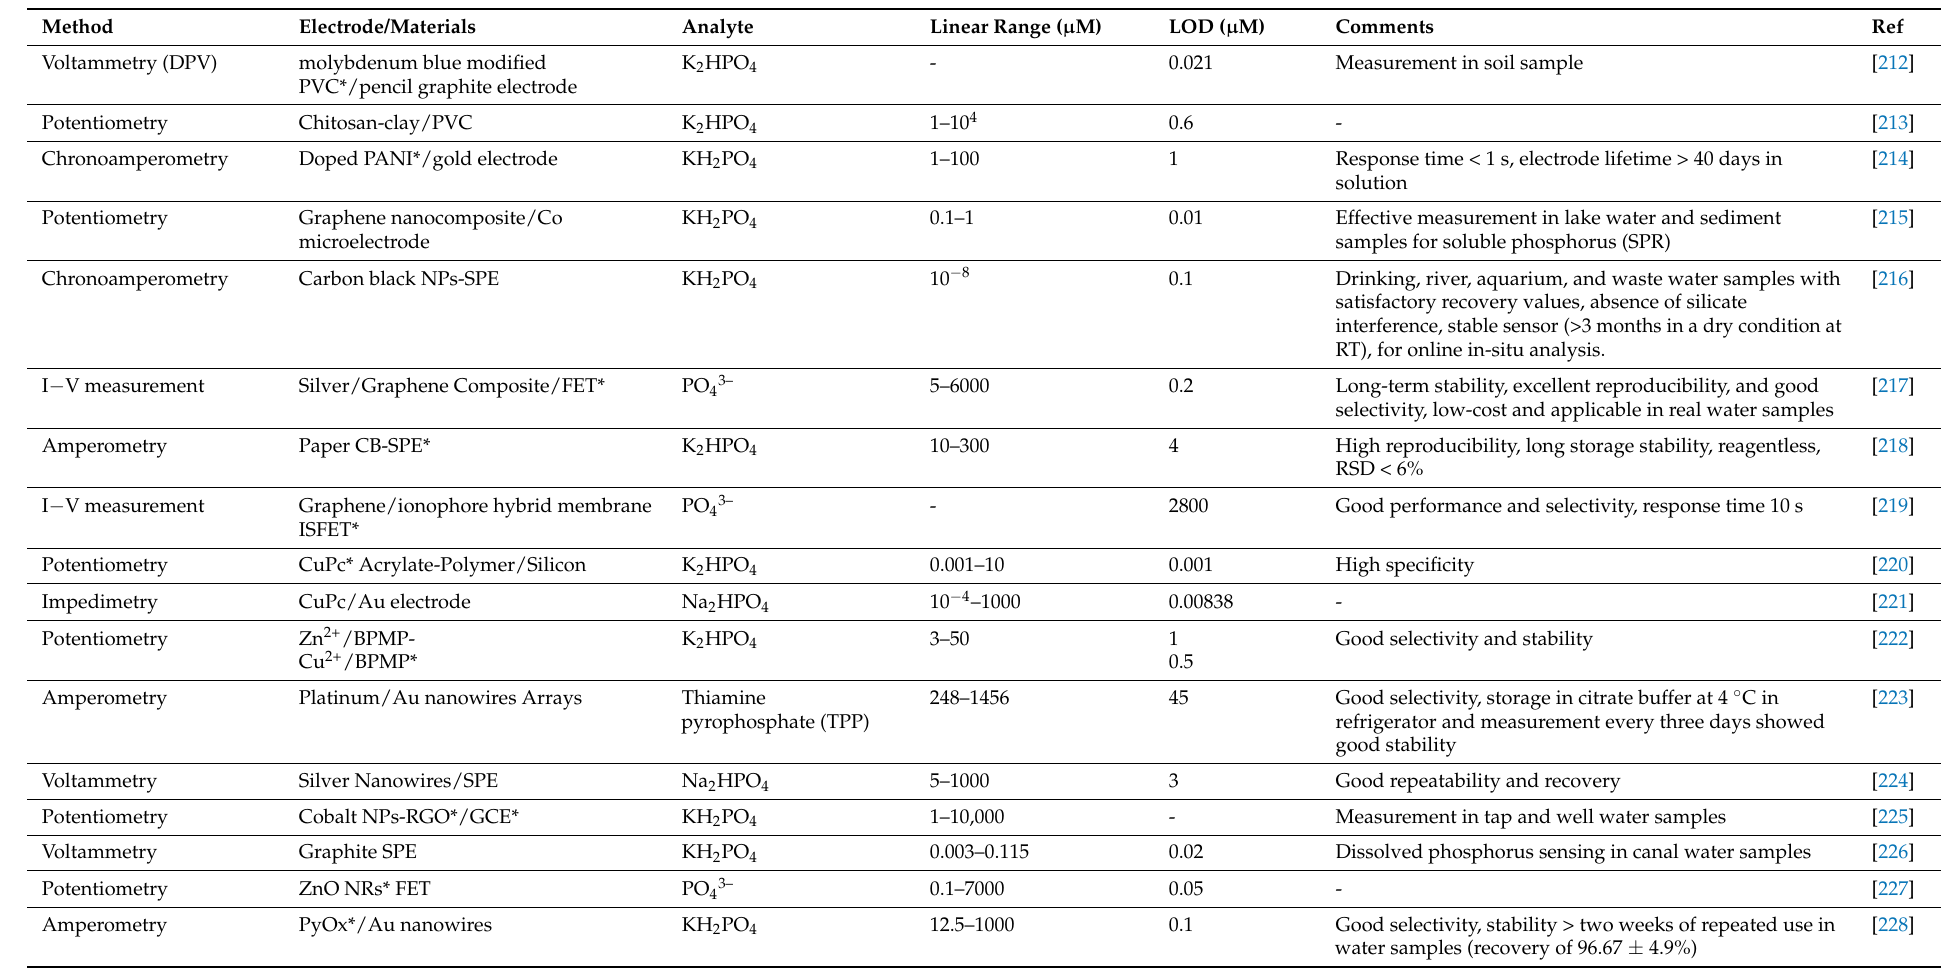
Table 6. Overview about nanomaterials-based sensors for phosphate ion